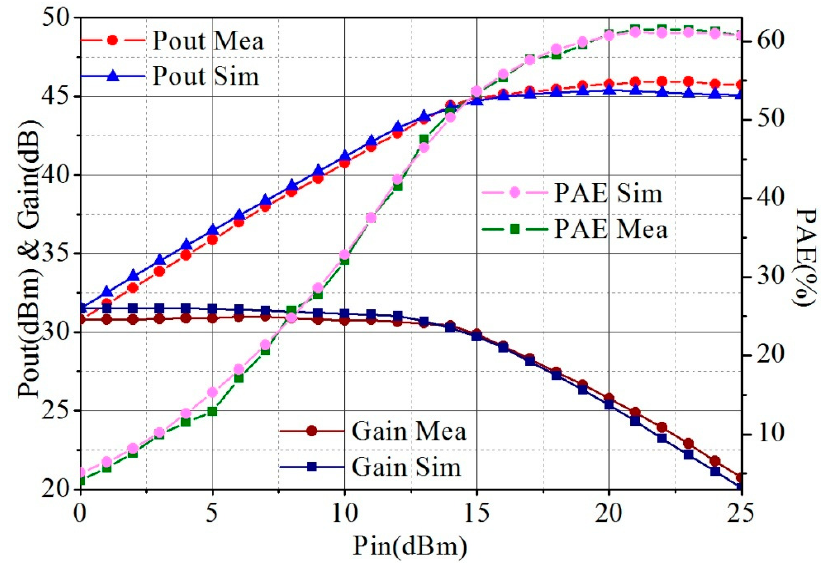
Figure 10. Simulated and measured Pout, PAE, and Gain curves versus Pin with 100 μ s pulse width and 10% duty cycle at 5.5 GHz.